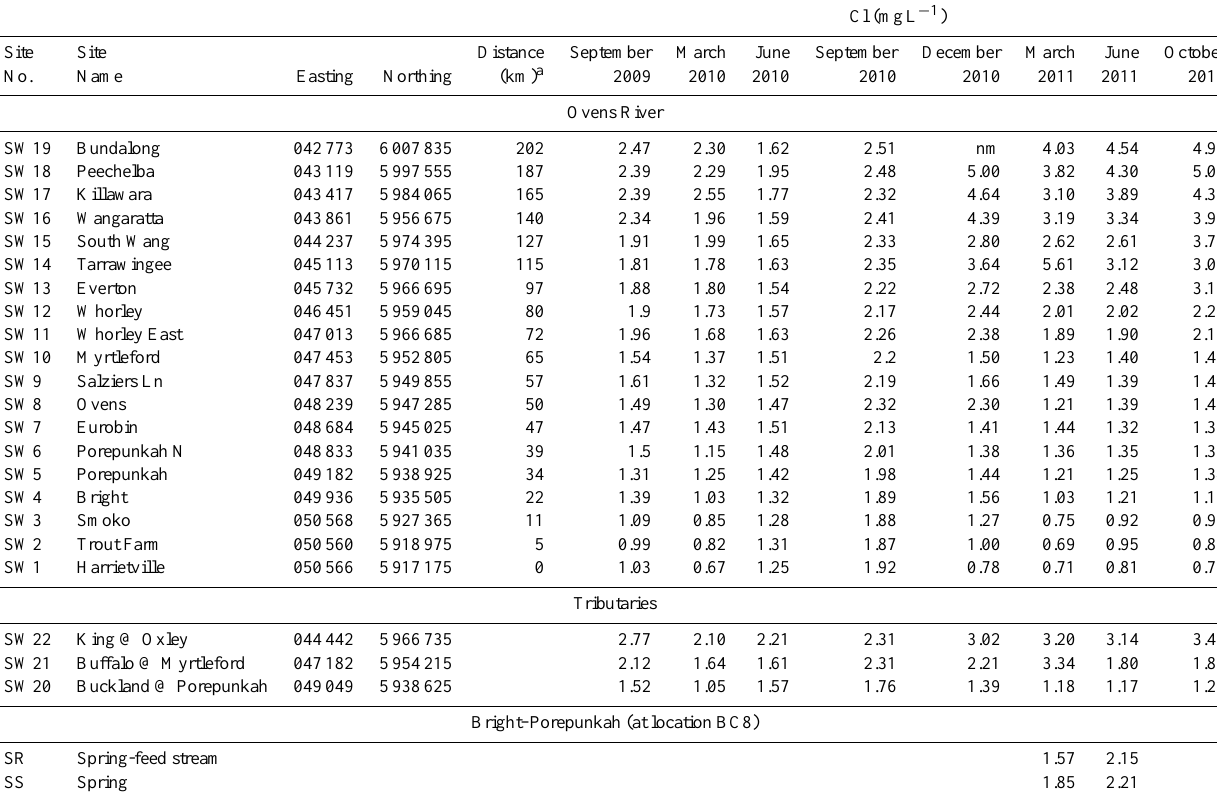
Table 3. Cl concentrations of the Ovens